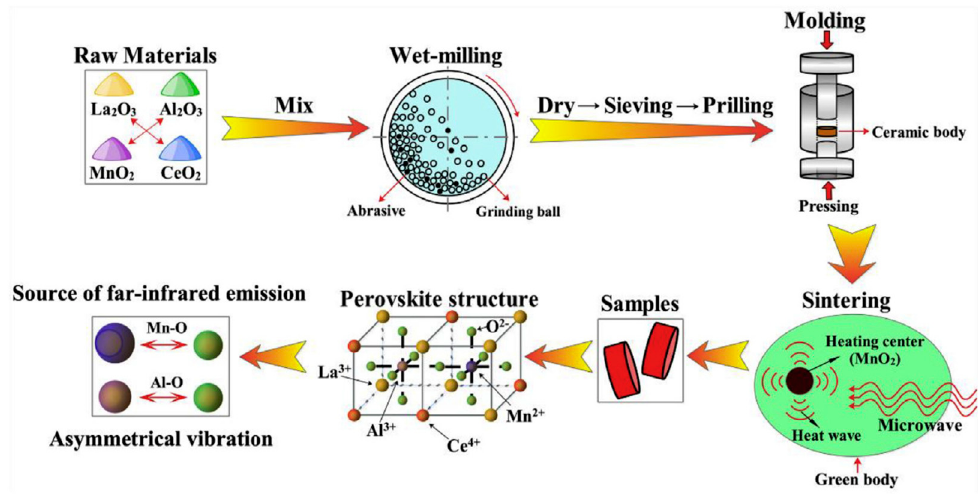
Figure 22. Schematic diagram for the synthesis of Ce/Mn-doped LaAlO 3 perovskite (Reprinted with permission from [78]).